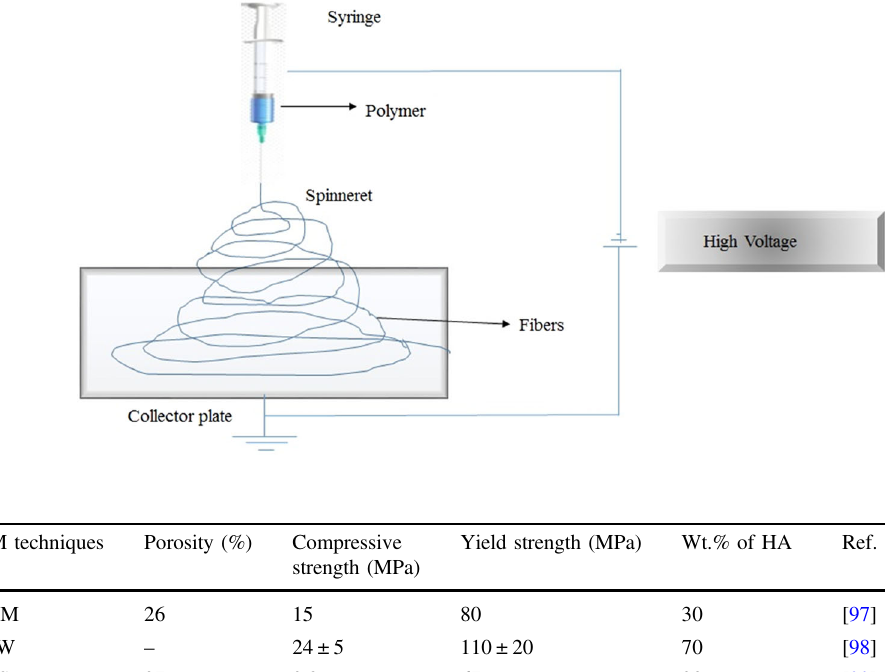
Fig. 5 Scheme of electrospining process for composite scaffold fabrication through fi ber deposition